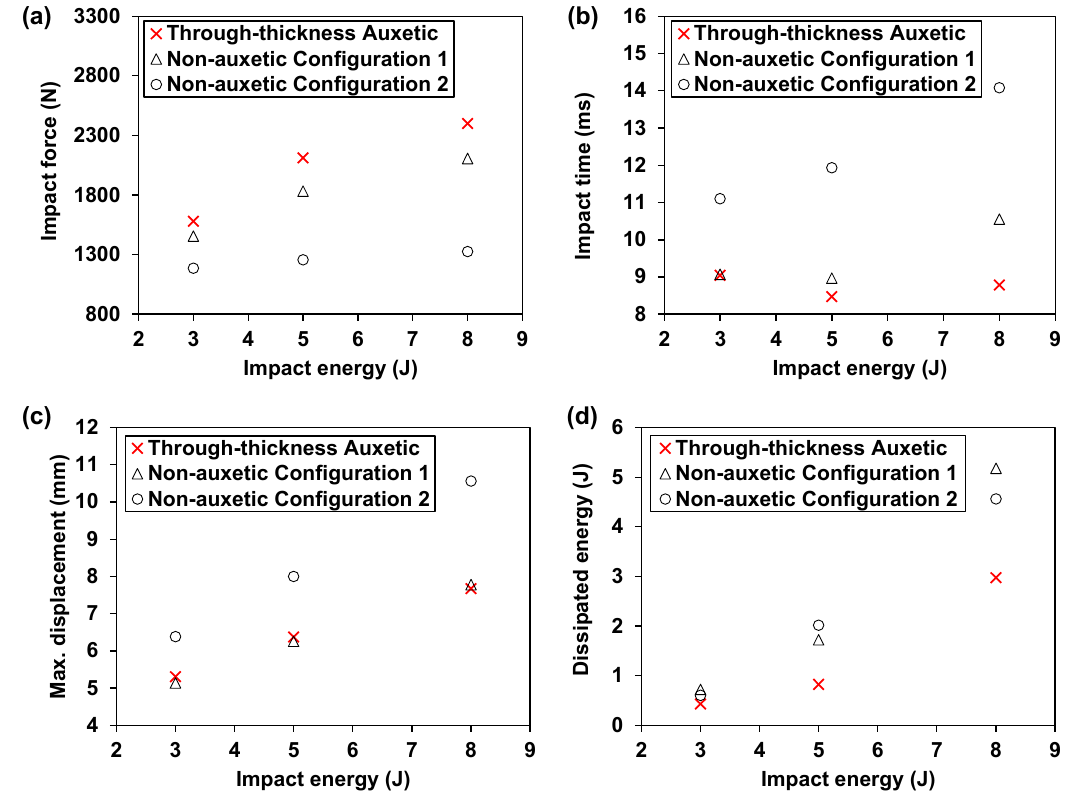
Figure 6. Effect of the through-thickness negative Poisson’s ratio on the global impact response: comparison between the auxetic and corresponding non-auxetic CFRP composite laminates: ( a ) impact load, ( b ) impact time, ( c ) maximum displacement, and ( d ) dissipated energy. Furthermore, the auxetic laminate shows consistently much lower maximum displace- ments than those of the non-auxetic Configuration 2 laminate, as depicted in Figure 6c. The reductions are 16.8%, 20.3%, and 27.4% at 3, 5, and 8 J, respectively. This indicates maximum displacement during low velocity impact. Moreover, this positive effect is more significant as the impact energy increases. For the Configuration 1 laminate, the maximum displacements are slightly lower (i.e., 3.2% and 1.7%) than those of the auxetic laminate at 3 and 5 J. However, when the impact energy rises to 8 J, the maximum displacement of the Configuration 1 non-auxetic laminate exceeds that of the auxetic laminate by 1.4%. The result suggests that both the negative Poisson’s ratio and the increased effective modulus (i.e., the transverse modulus of Configuration 1 laminate is higher than that of the auxetic laminate, see Table 2) are beneficial for reducing the maximum displacement. Specifically, at lower energy levels (i.e., 3 and 5 J), the increased transverse effective modulus is a more dominating factor, whereas at a higher energy level (i.e., 8 J), the effect of the through- thickness negative Poisson’s ratio becomes more significant than the effect of the increased modulus, which contributes to a more significant reduction of the maximum